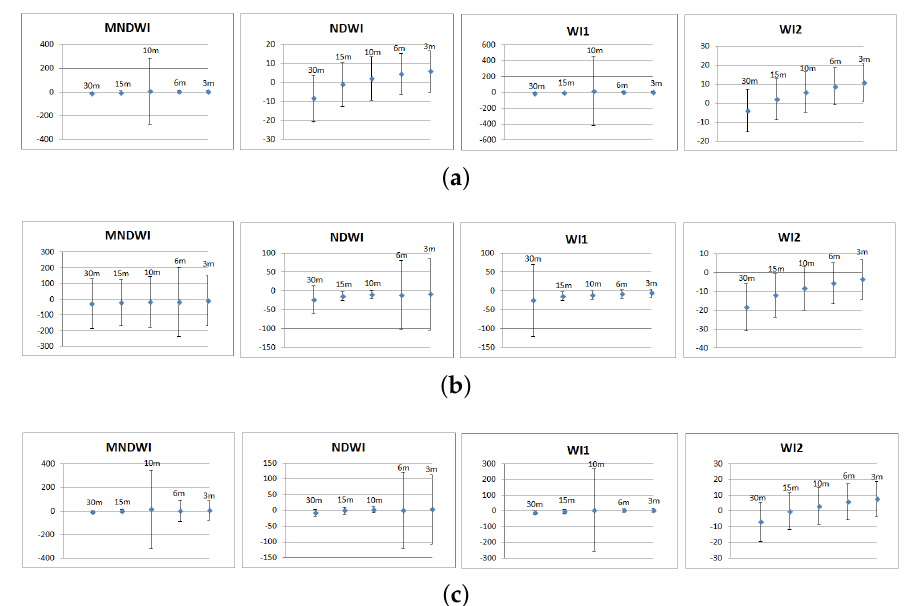
Figure 19. The graphs show the mean distance and standard deviation behavior according to the different factor of bicubic interpolation used on the Landsat images to analyze accuracy assessment in the coastline detected in Ebro river delta. ( a ) The image captured on 13 August 2007. ( b ) The image captured on 20 June 2008. ( c ) The image captured on 15 June 2012. Pixel